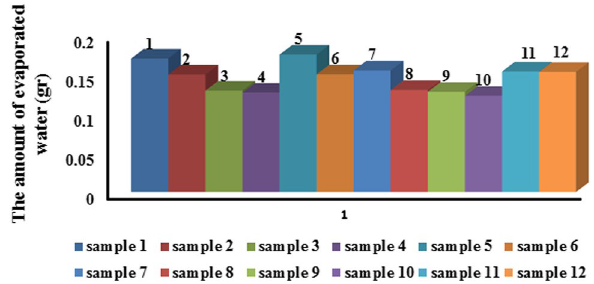
Fig. 3 Amount of evaporated water from PPG samples at atmos- pheric condition